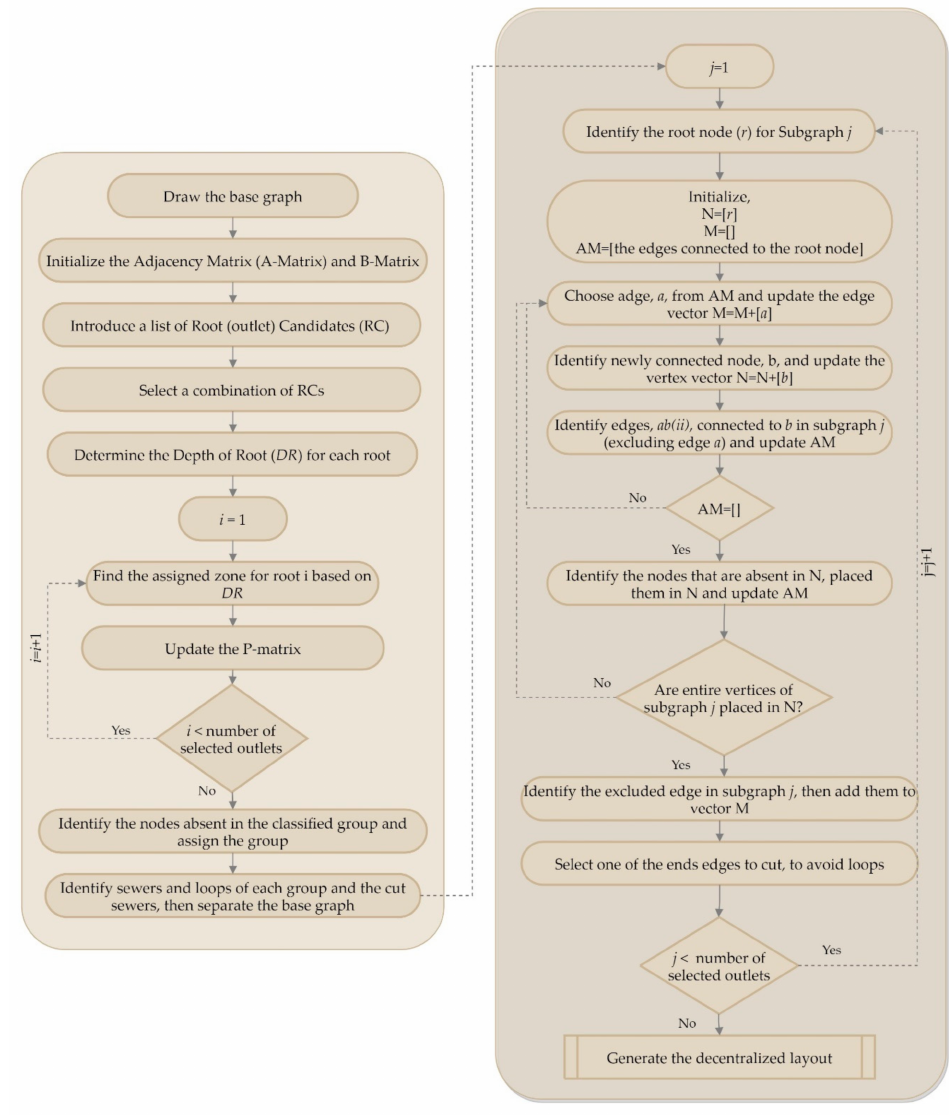
Figure 6. Flowchart of the proposed algorithm for generating the spanning